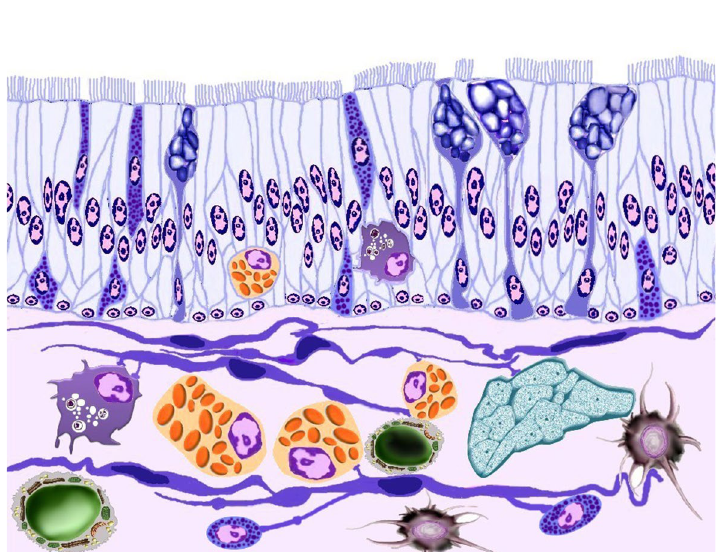
Figure 15. An illustration showed the relation between TCs and other cells in the intestinal blub. TCs established contact with neuroendocrine cells (violet granular cells), nerve fibers (green colored), masts cells (orange colored), dendritic cells (brown colored), lymphocytes (green colored), macrophages (violet